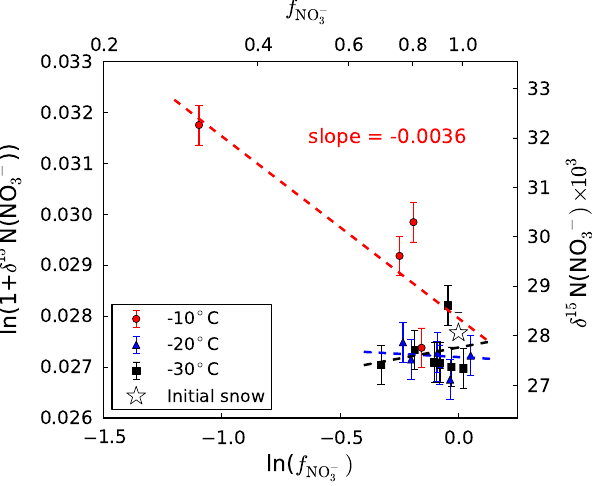
) and 3 ) are plotted in a loga- NO − 3